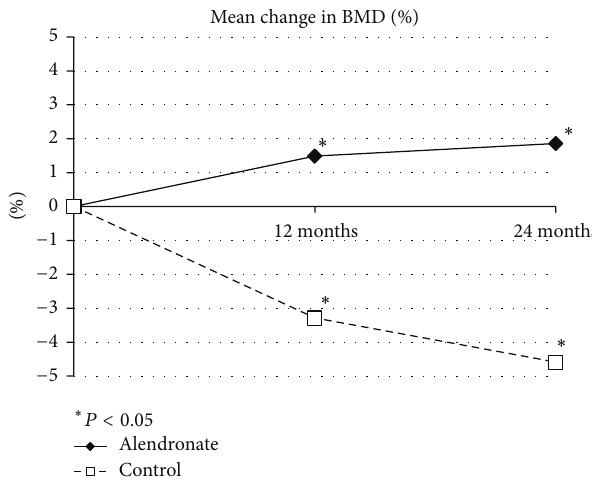
Figure 3: Mean change in bone mineral density (BMD).